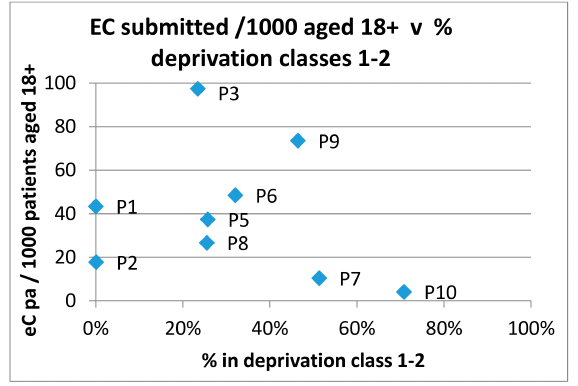
Figure 8. eConsult submission rates versus percentage of patients in the most deprived quintiles.